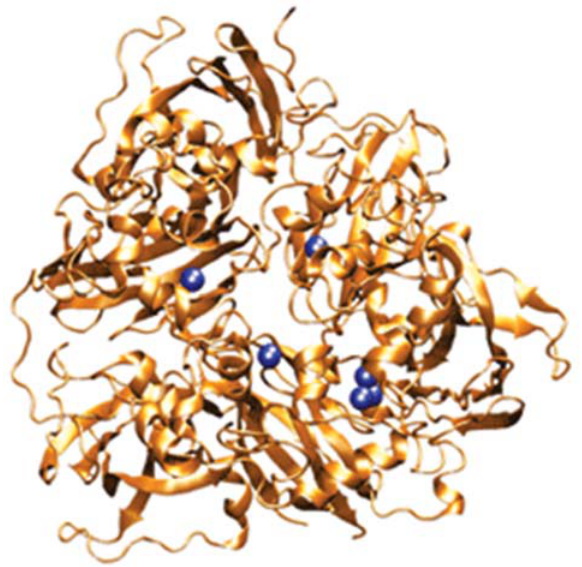
Figure 1. Crystallographic three-lobed structure of human holoceruloplasmin, showing the positions of the 6 internal (integral) copper atoms (dark blue), and based on the studies of Zaitseva et al. [16]. Reprinted with permission from ACS C & E News (8533scicon_cp). Two additional “labile” copper binding sites on the surface of the molecule have also been identified in vitro [17–19], although it is unclear that these are normally occupied in vivo.